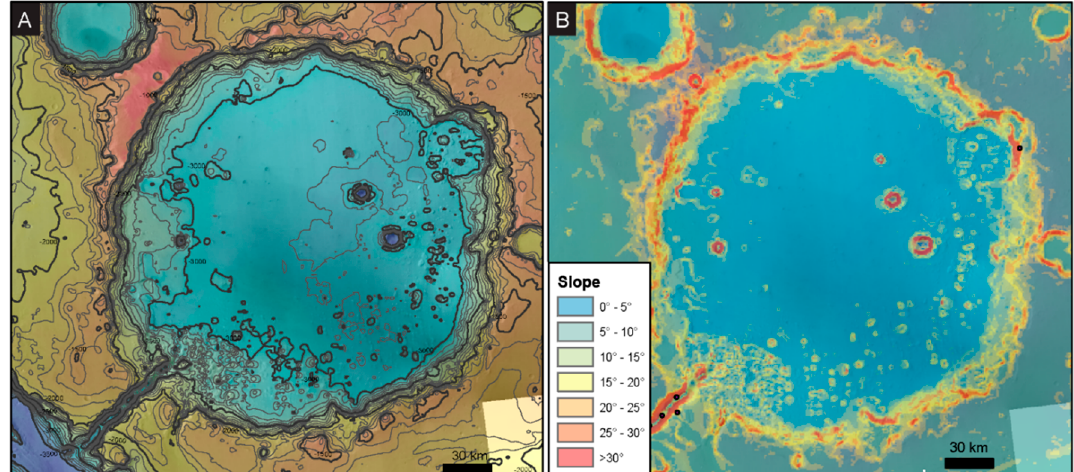
Figure 2. Topography and slopes in Galilaei crater. ( A ) A colorized elevation map of Galilaei crater (see color bas in Figure 1A) with overlain elevation contours. Contour interval is 100 m, and elevation data is derived from HRSC. Note the <100 m relief on most of the crater floor. ( B ) Slope map of the study area generated from the DEM in ( A ). Slopes are highest along the crater wall and outflow channel (Tana Vallis) walls. The crater wall in the northwest of the crater, where chaos blocks are absent from the crater floor, is notably steeper than the southeastern crater wall, where chaos blocks are abundant.